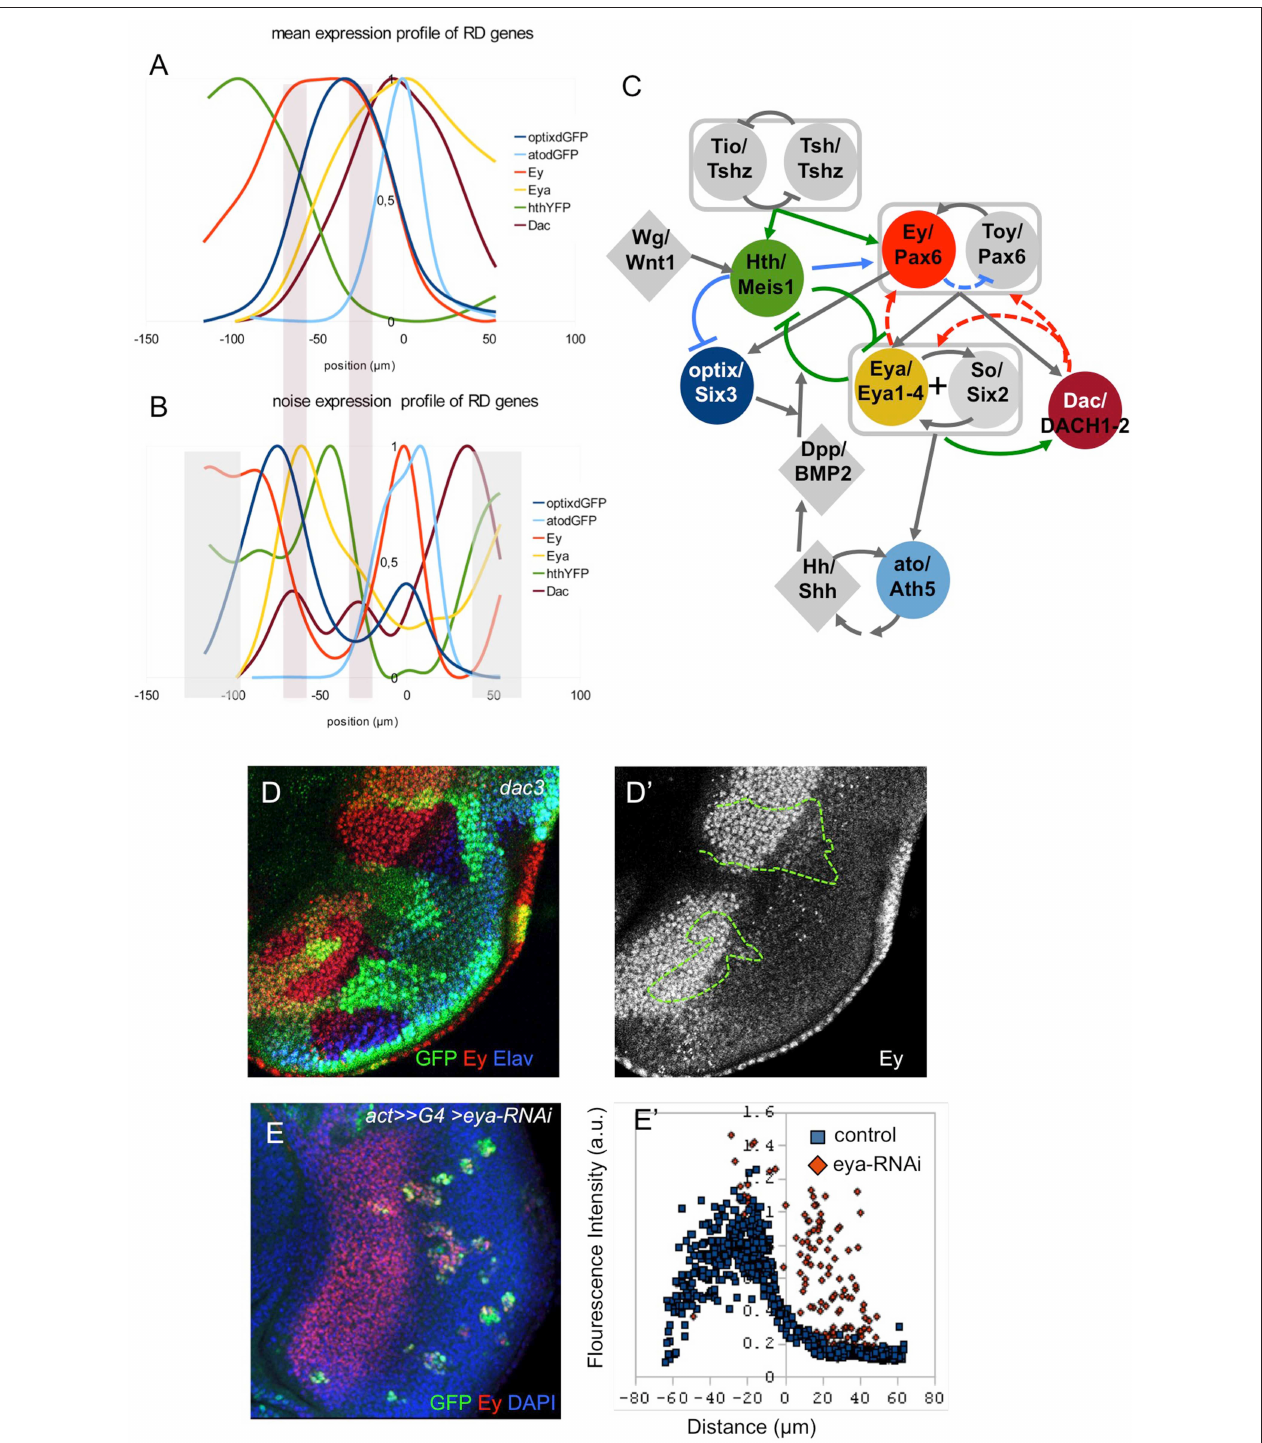
FIGURE 4 | The RDGN gene expression profiles. Normalized gene expression (A) and noise (Fano factor; B ) profiles relative to the MF (x = 0). The two bars spanning A and B mark the two “noise” peaks for the dac gene. (C) Revised schematic RDGN. Genes are named as “Drosophila gene name/vertebrate gene homolog.” Colored nodes are genes studied in this work. Boxes group genes with partly redundant functions ( tsh/tio ; ey/toy ) or working jointly ( eya/so ). Green links are regulatory relationships supported by our study. Blue links are suggested relationships, including a potential negative regulation from ey to toy ensuring constant levels of Pax6 function. Red links are not supported (see D,E ), at least, for eye development during the third larval stage. (D) Disc containing dac 3 - mutant clones (marked by the